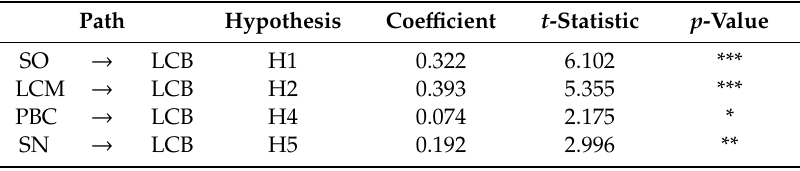
Table 13. Results of hypothesis test in the final model.